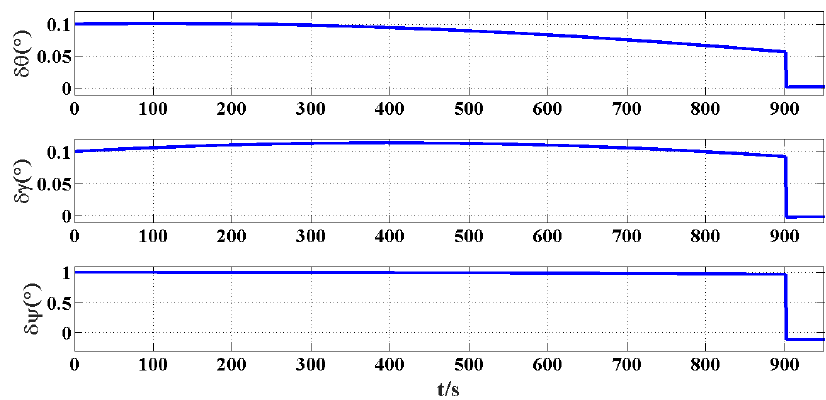
Figure 4. Attitude error of in-motion alignment of uniform linear motion.